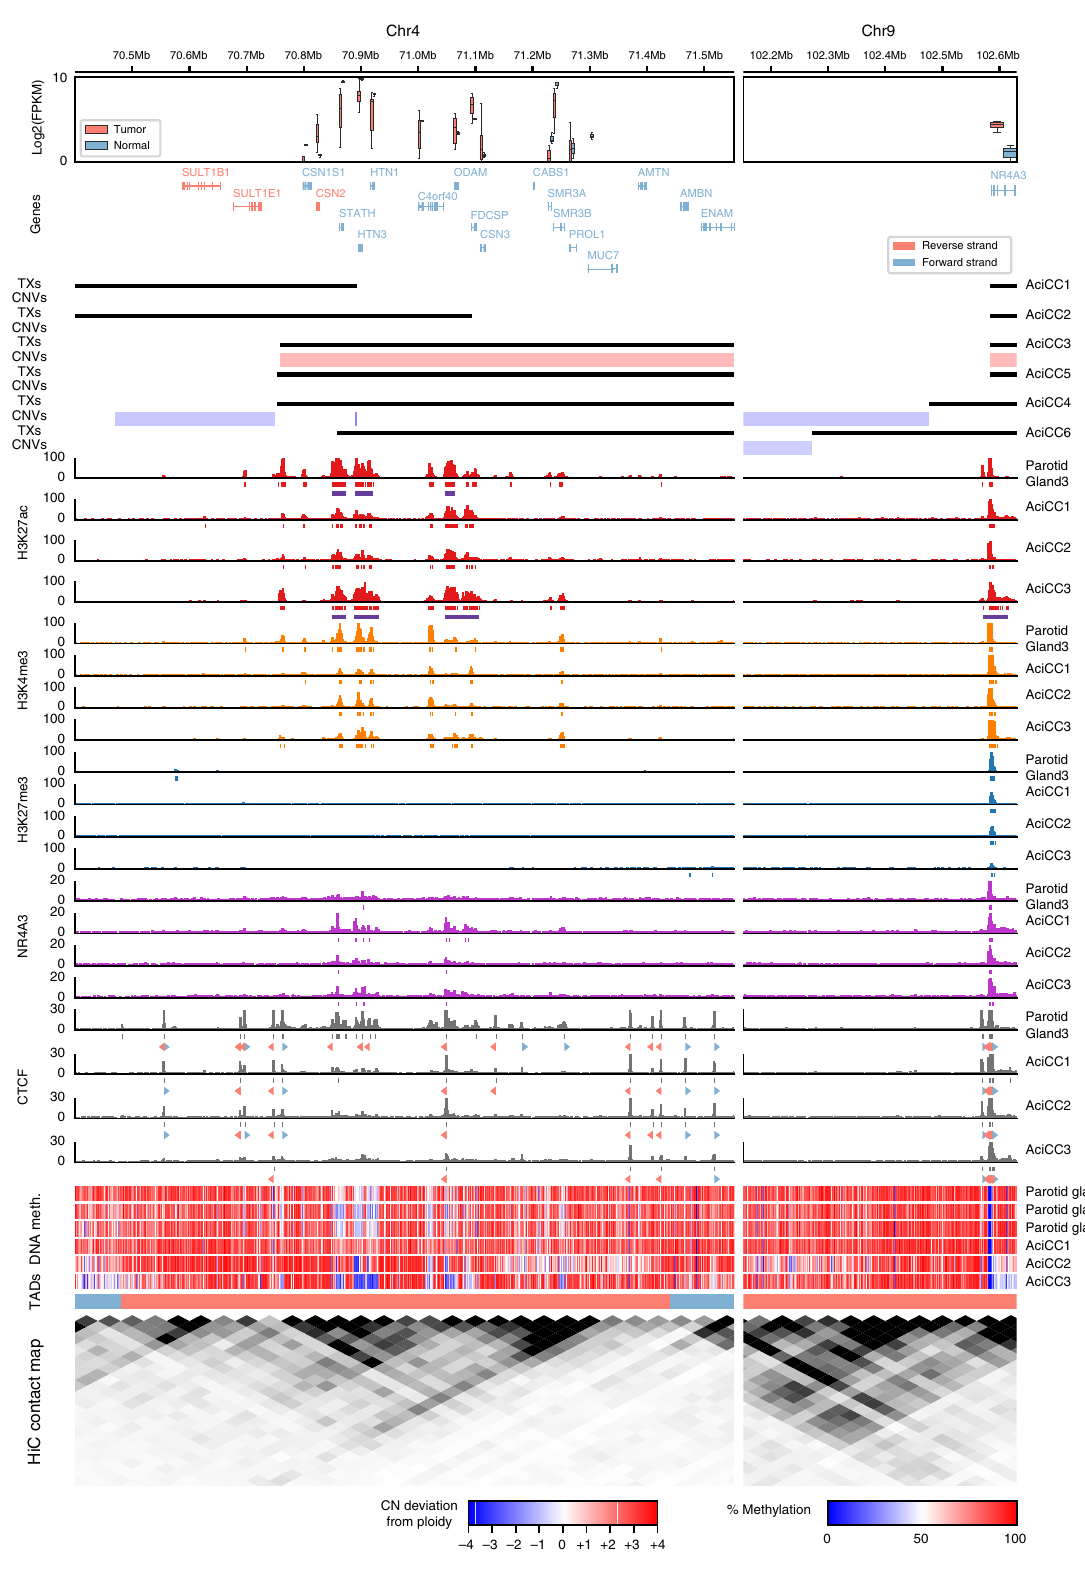
differential H3K27ac and NR4A3 peaks (Supplementary Figure 3), and a signi fi cant enrichment of higher H3K27ac and NR4A3 peaks was observed among upregulated genes in the tumors. Approxi- mately 25% and 15% of upregulated genes were associated with upregulated H3K27ac and NR4A3 peaks in the tumors, respectively (Fig. 6b). While ~ 25% of downregulated genes were associated with